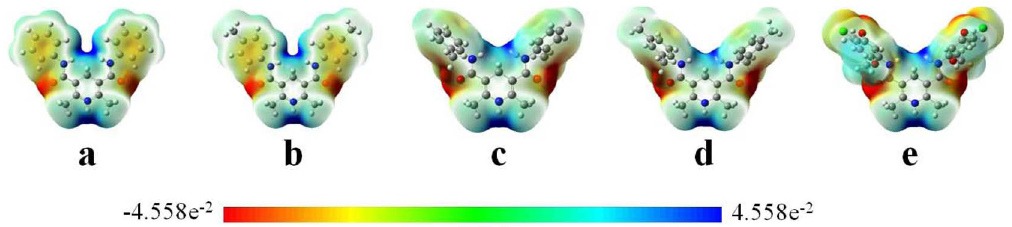
Figure 6. Molecular electrostatic potential of a–e.